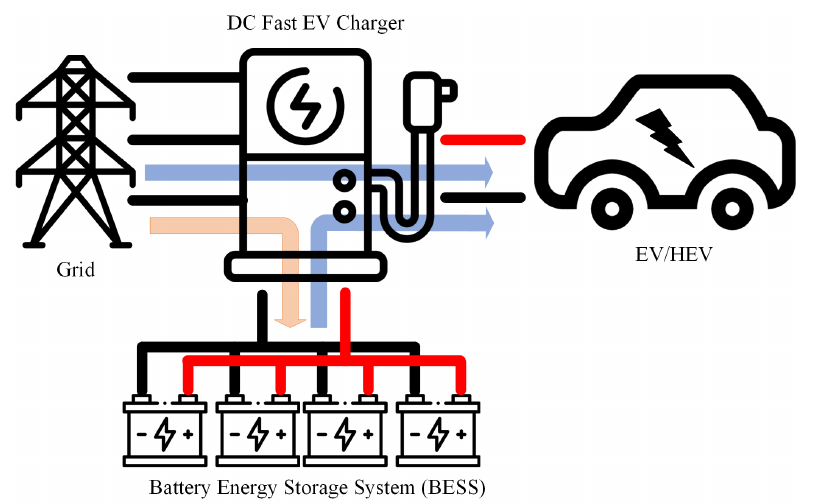
Figure 2. A representation of grid-connected DC-Fast charger with local BESS. Light blue arrows show the direction of the active power flow when EV is connected. Light orange arrow shows the direction of active power flow when EV charging is